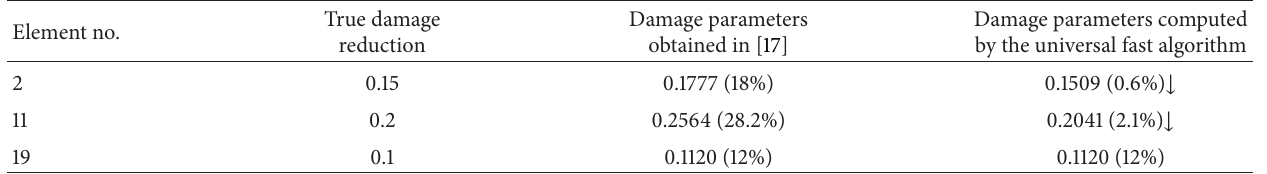
Table 5 for comparison. As before, the new damage parameter 𝛼